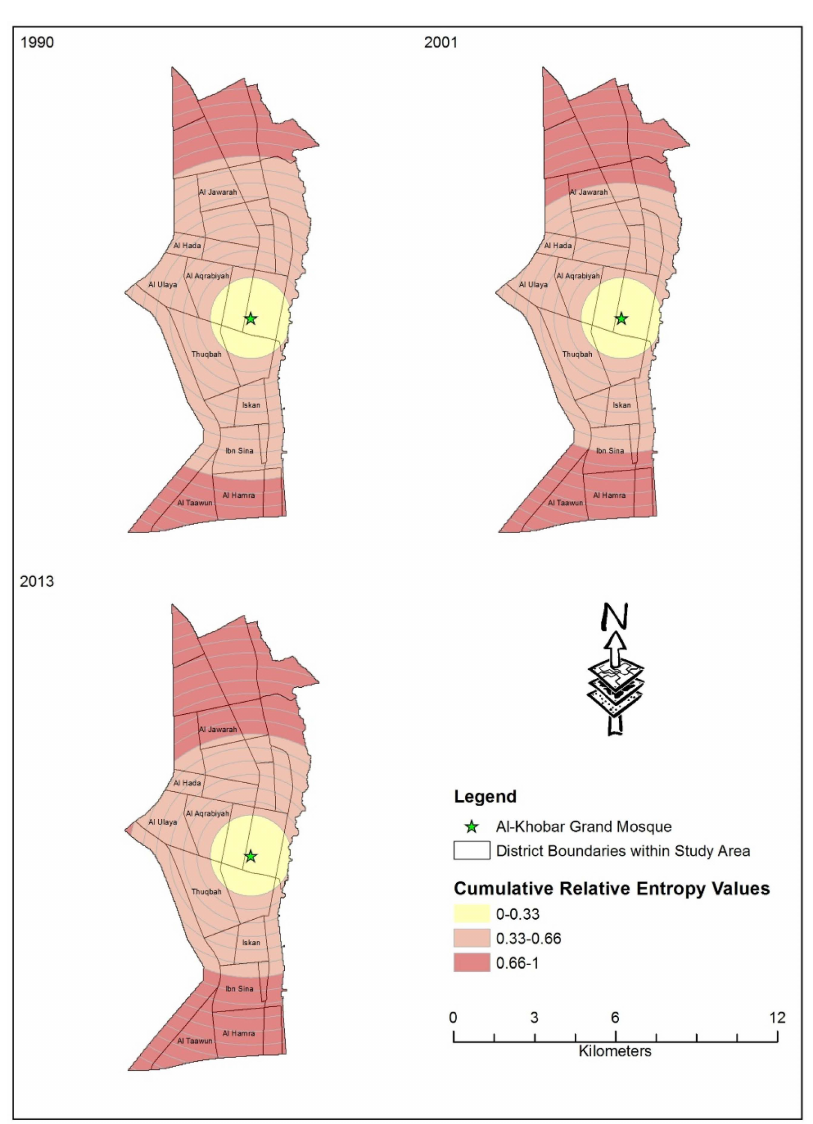
Figure 4. The distribution of the cumulative Shannon’s entropy values in the study